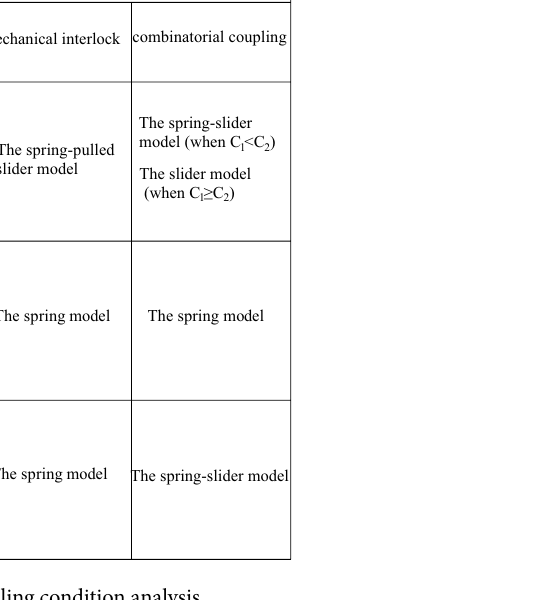
Figure 11. Summary of interface coupling condition analysis.